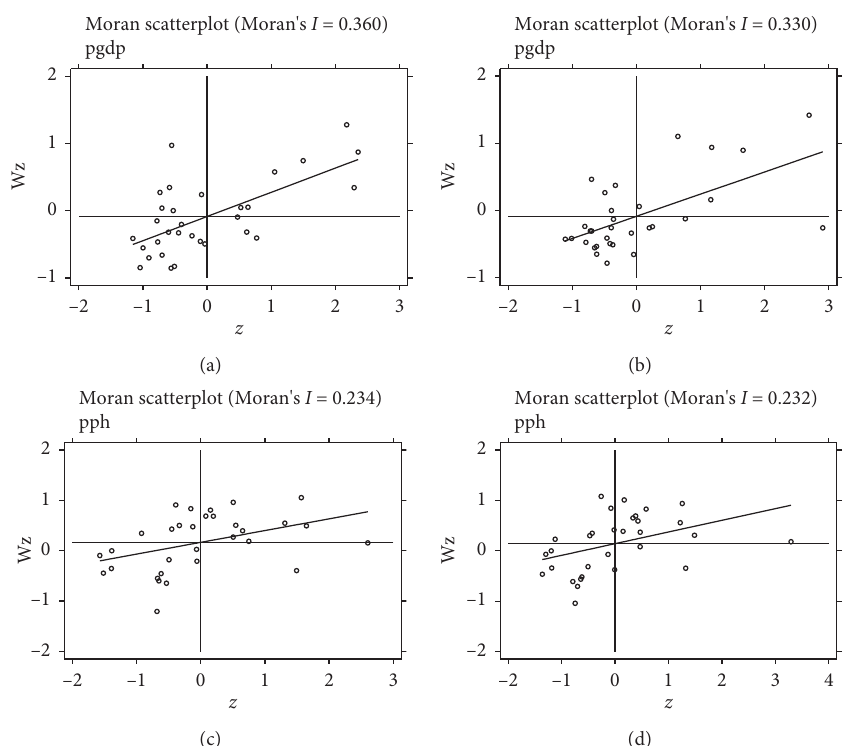
Figure 1: Local Moran scatter diagrams of pgdp and pph. (a) 2015 pgdp. (b) 2019 pgdp. (c) 2015pph. (d) 2019